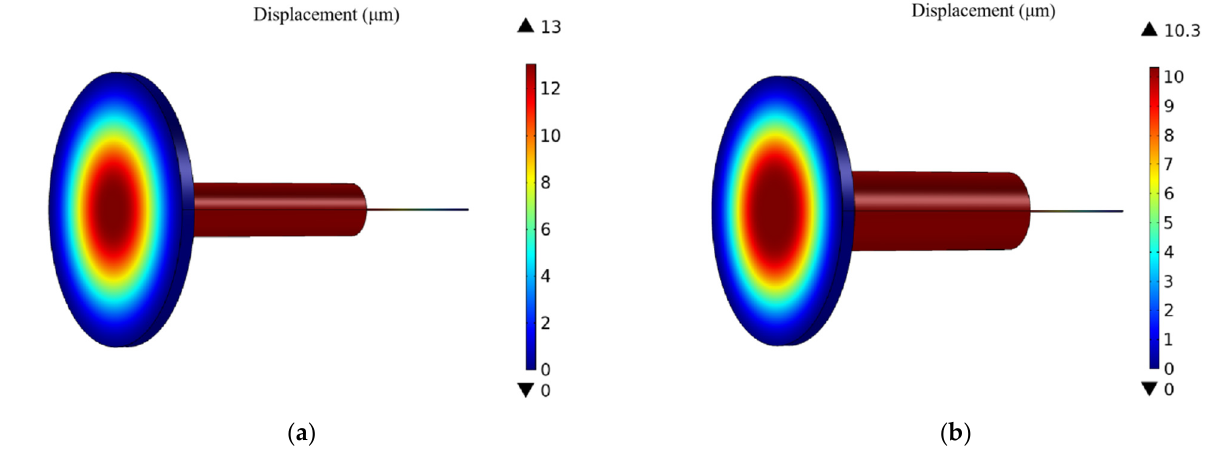
Figure 8. Pressure displacement diagram of the sensor surface. ( a ) The radius of the section is 2 mm. ( b ) The radius of the section is 3 mm.